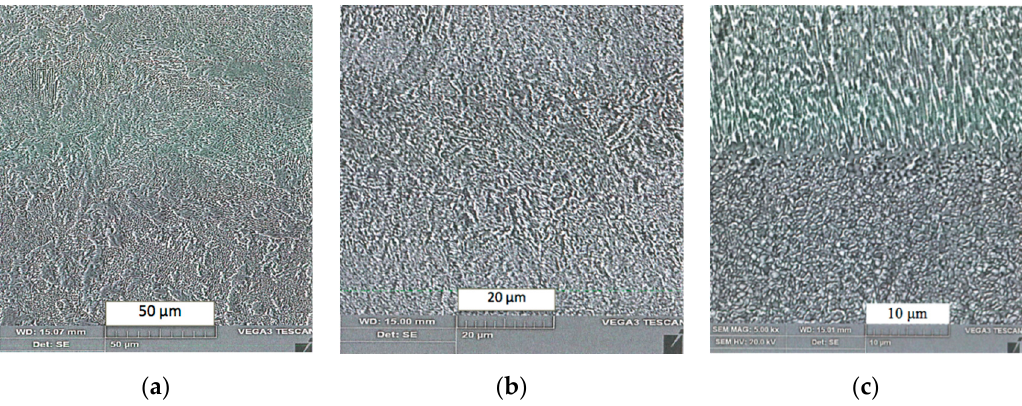
Figure 10. The SEM image of samples of different groups: ( a ) group1; ( b ) group 2; ( c ) group 3.